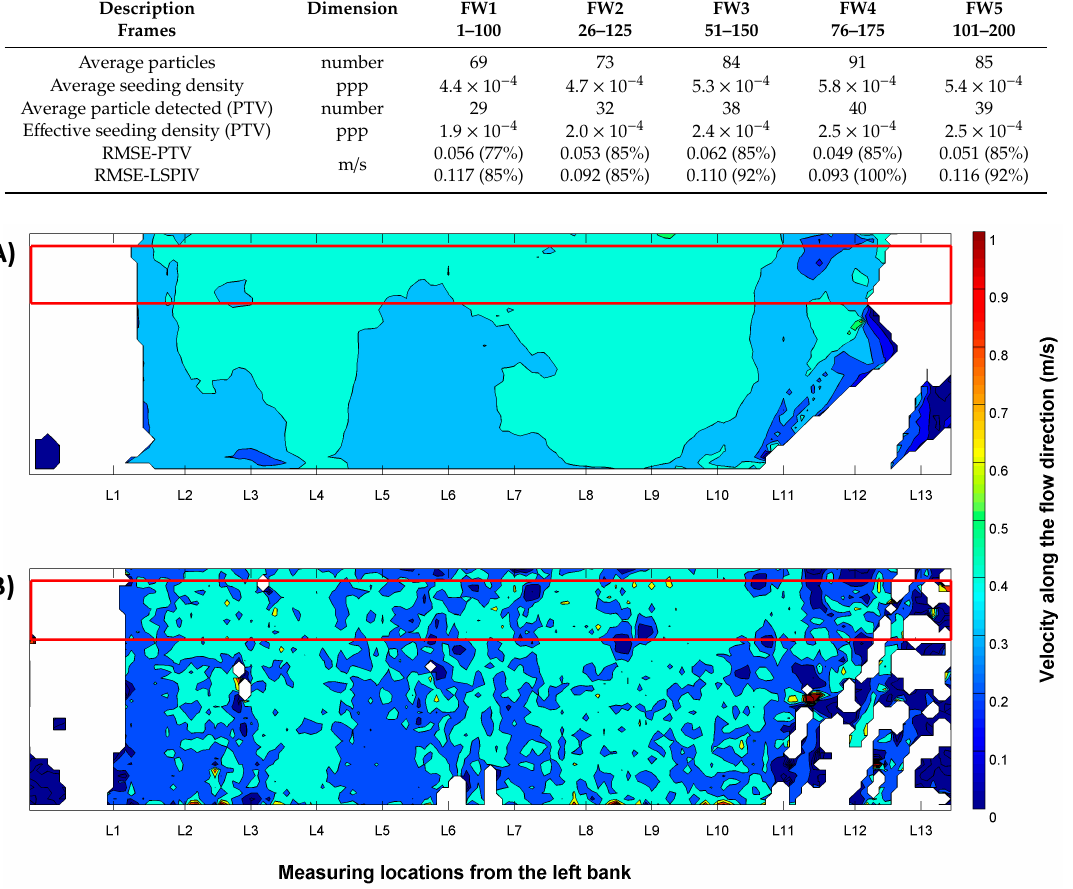
Figure 6. Examples of flow velocity maps calculated with ( A ) PTV and ( B ) LSPIV techniques for frame window FW4 on the Noce River. Red squares represent the ROI considered for the analysis.